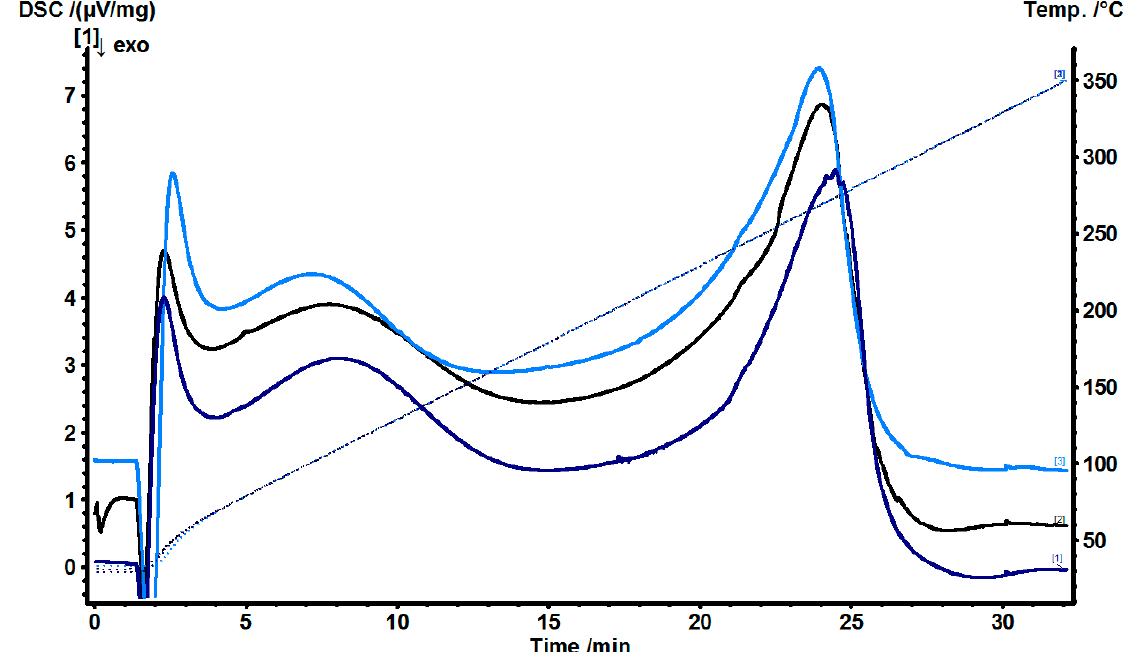
Figure 3. Differential scanning calorimetry (DSC) thermograms of Film 1 (bottom line) contained doxycycline in chitosan, gelatin, povidone, glycerin and Eudragit ® RS 12.5: Film 2 (middle line) contained doxycycline, β -cyclodextrin and HPMC microparticles in chitosan, gelatin, povidone, glycerin and Eudragit ® RS 12.5; and Film 3 (top line) was the same as in Film 2, but the manufacturing of microparticles was performed using sodium thiosulfate, MgCl 2 in 2% HPMC with Eudragit ® RS 12.5.